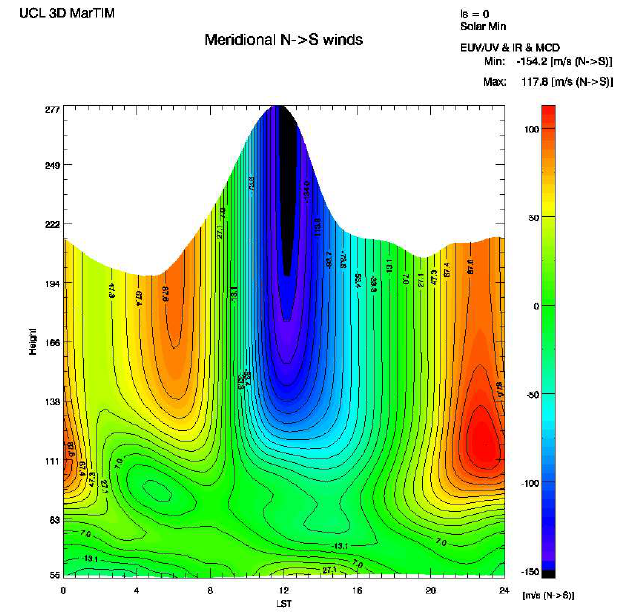
Fig. 13. The zonal wind velocity, local solar time (LST) vs. height, from MarTIM+MCD, for solar minimum and L s =0 ◦ at +45 ◦ lati- tude.